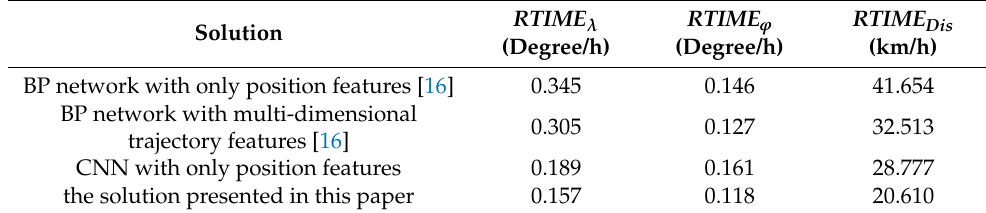
Table 4. Performance comparison with other